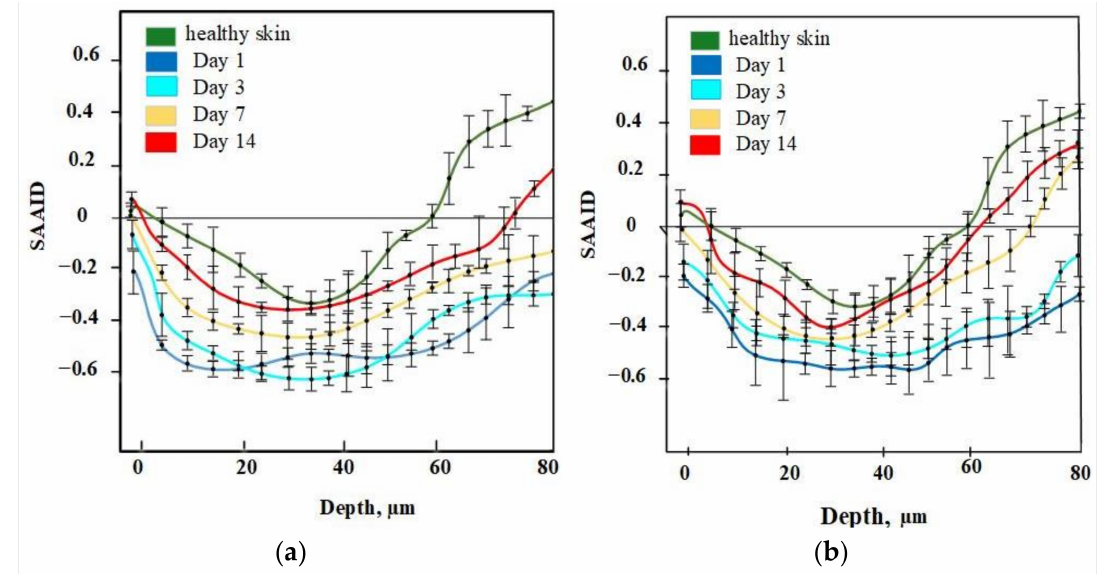
Figure 7. ( a ) SAAID for control group; ( b ) SAAID for LDPDT–5-ALA/4 J/cm 2 group.